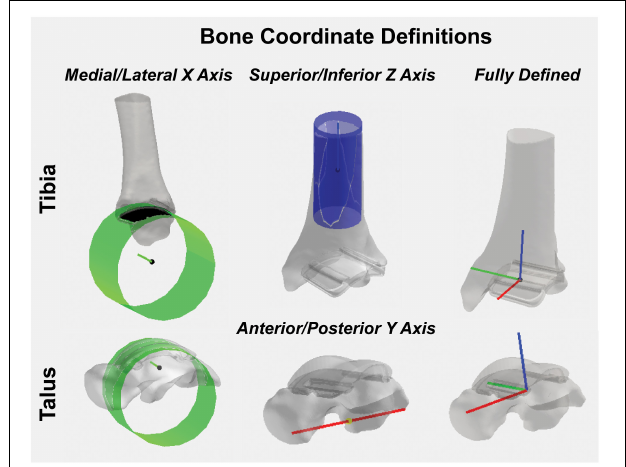
FIGURE 8 | Tibial and talar hybrid model coordinate system definitions based on an anatomical and implant landmark approach. Cylindrical fit approaches were used to identify medial/lateral axes based on the implant articular surface curvature. A tibial shaft cylindrical fit defined the superior/inferior axis. Anatomical landmarks on the inferior surface of the talus defined the anterior/posterior axis. Cross-products yielded fully defined hybrid model coordinate